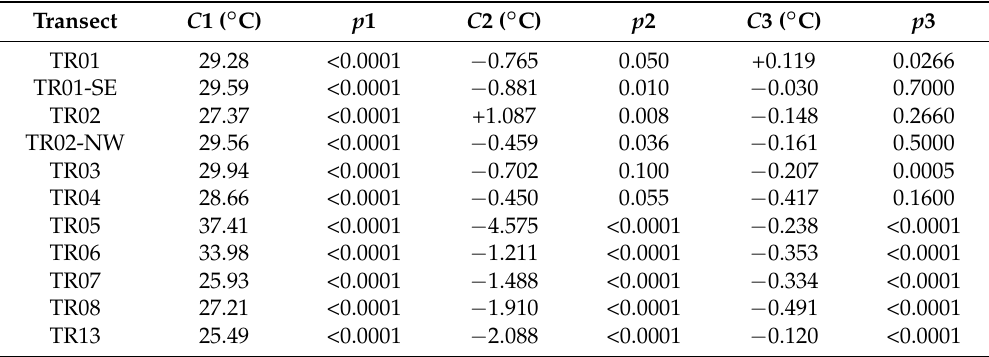
Table 7. Equation (3) applied to a 500-m analysis of air temperature correlation to albedo and canopy cover without weighting (without and with correction for wind speed and direction). Coefficients C2 and C3 are, respectively, the responses of observed air temperature to a 0.1 increase in neighborhood-scale albedo and canopy